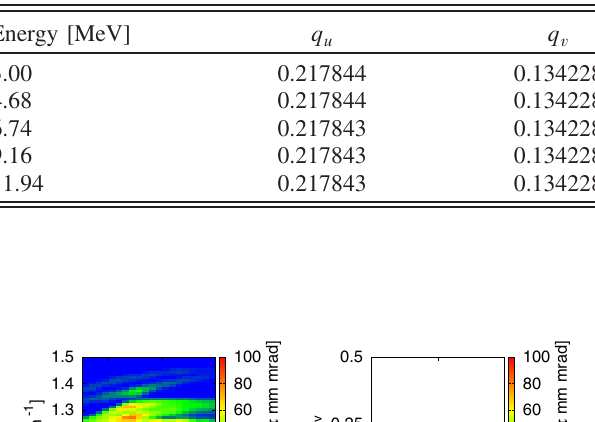
TABLE VII. Transverse eigentunes depending on energy.